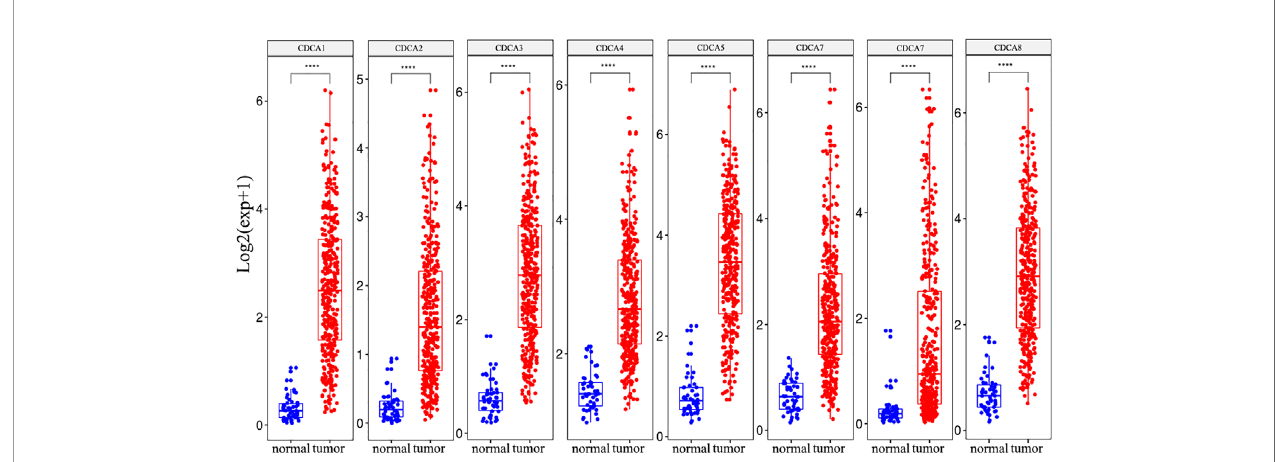
FIGURE 3 | The CDCAs have signi fi cant differences between HCC and normal tissue. Meanwhile, eight genes of CDCAs have over-expression in the tumor sample. T-test, ****p < 0.0001.